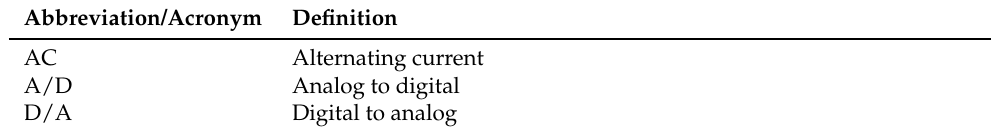
Table 1. Definitions of abbreviations and acronyms used in the present